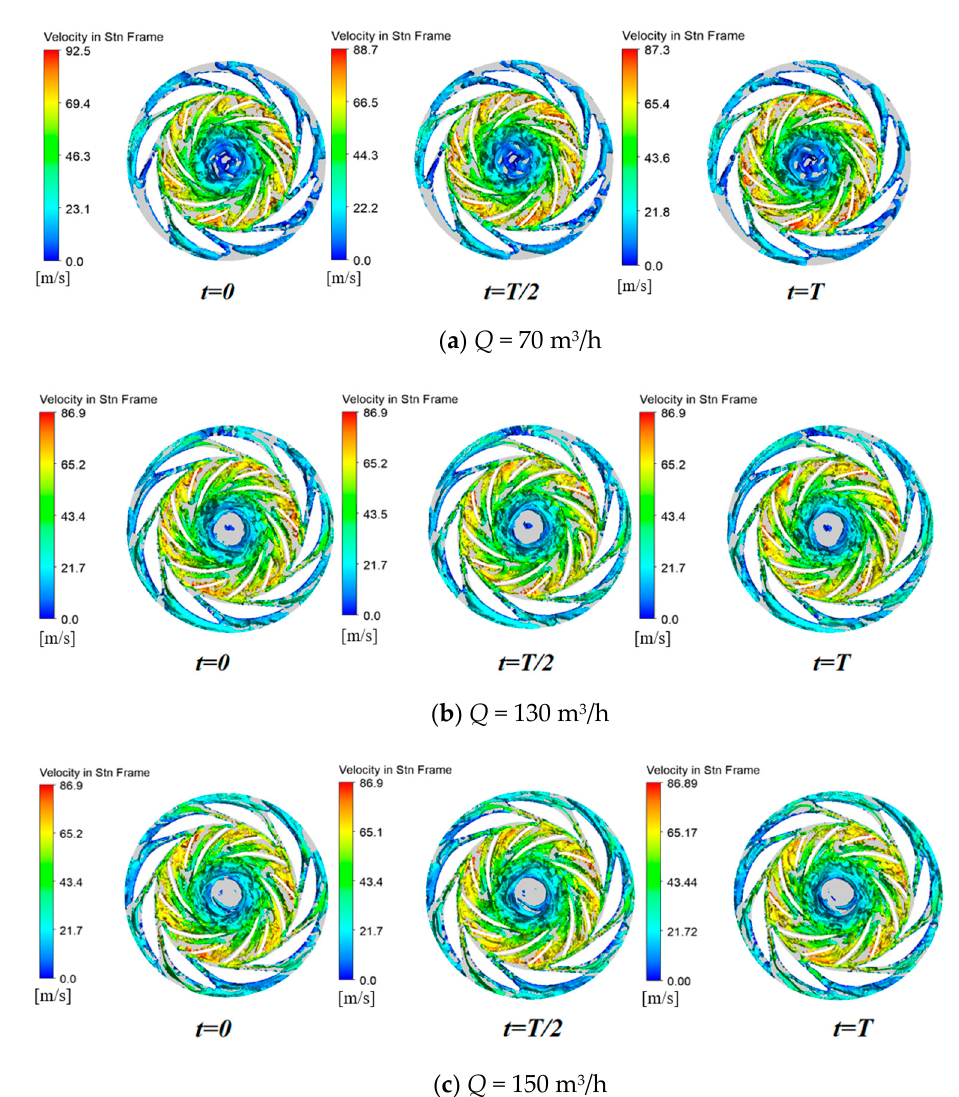
Figure 14. Vorticity distribution over a period of different flow rates.